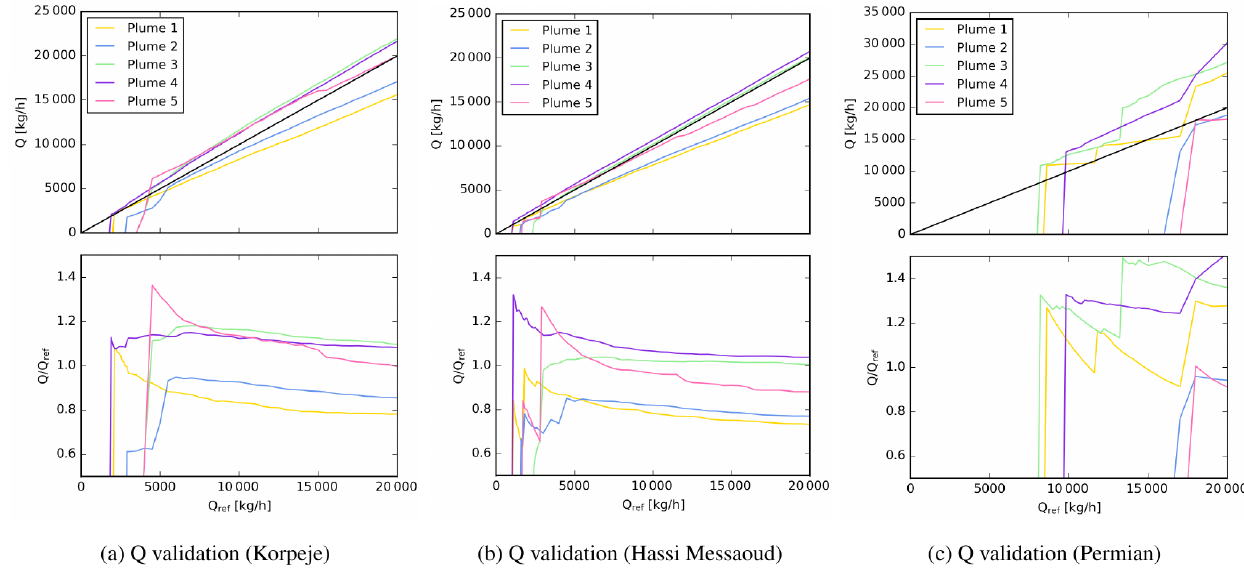
Figure 9. Q validation against reference values for a variety of plume shapes with a conservative detection masking criteria as detailed in Sect.